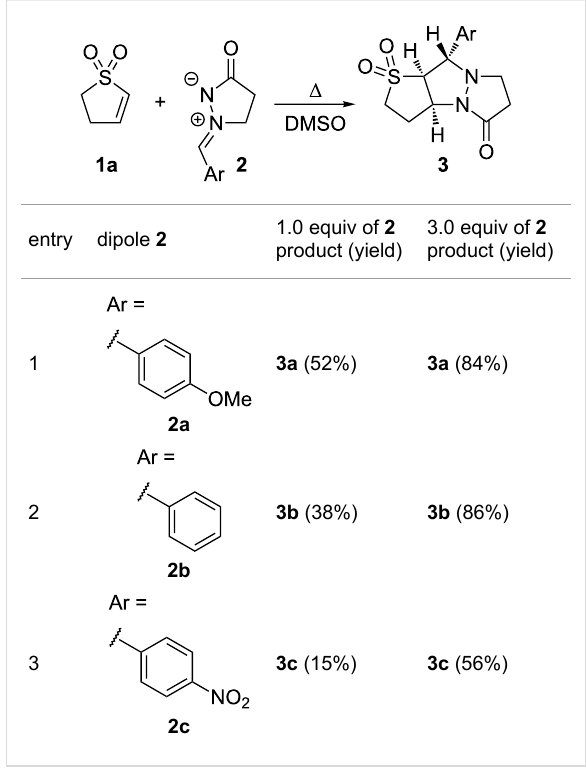
Table 1: Effect of dipole equivalents and electronics on the cycloaddi- tion